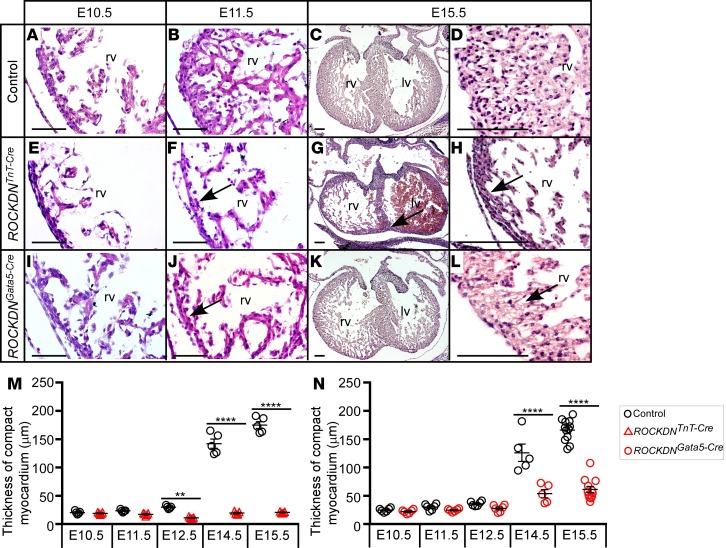
Downregulation of ROCK1 and ROCK2 in embryonic cardiomyocytes leads to defects in the ventricular wall during embryogenesis.(A–L) Transverse sections from embryos were stained with H&E, and a representative high-power image of the right ventricle is shown for each genotype and embryonic age. At E10.5, the heart morphology was comparable among controls (A) and ROCKDNTnT-Cre (E) and ROCKDNGata5-Cre (I) mutants. A reduction in myocardial thickness was visually evident throughout both ventricles at E11.5 in ROCKDNTnT-Cre (arrow in F) and ROCKDNGata5-Cre (arrow in J) mutant hearts compared with control hearts (B). Reduced myocardial thickness was still present at E15.5 in ROCKDNTnT-Cre (G and H) and ROCKDNGata5-Cre (K and L) mutants compared with control hearts (C and D). The ROCKDNTnT-Cre mutants had no defined interventricular sulcus (arrow in G). The severity of myocardial wall thickness was more prominent in ROCKDNTnT-Cre hearts than ROCKDNGata5-Cre mutants (compare arrows in H and L). (M and N) Myocardial wall measurements confirmed that the compact myocardium was significantly thinner in ROCKDNTnT-Cre mutants at E12.5, E14.5, and E15.5 (M), and at E14.5 and E15.5 in ROCKDNGata5-Cre mutants (N), compared with littermate control embryos. E10.5 n = 5, E11.5 n = 5, E12.5 n = 5, E14.5 n = 5, E15.5 n = 5 for ROCKDNTnT-Cre mutants and littermate controls; and E10.5 n = 6, E11.5 n = 6, E12.5 n = 6, E14.5 n = 5, E15.5 n = 12 for ROCKDNGata5-Cre mutants and littermate controls. Data are presented as mean ± SEM. **P < 0.01, ****P < 0.0001 by 1-way ANOVA with Bonferroni’s correction for multiple comparisons. rv, right ventricle; lv, left ventricle. Scale bars: 100 μm.